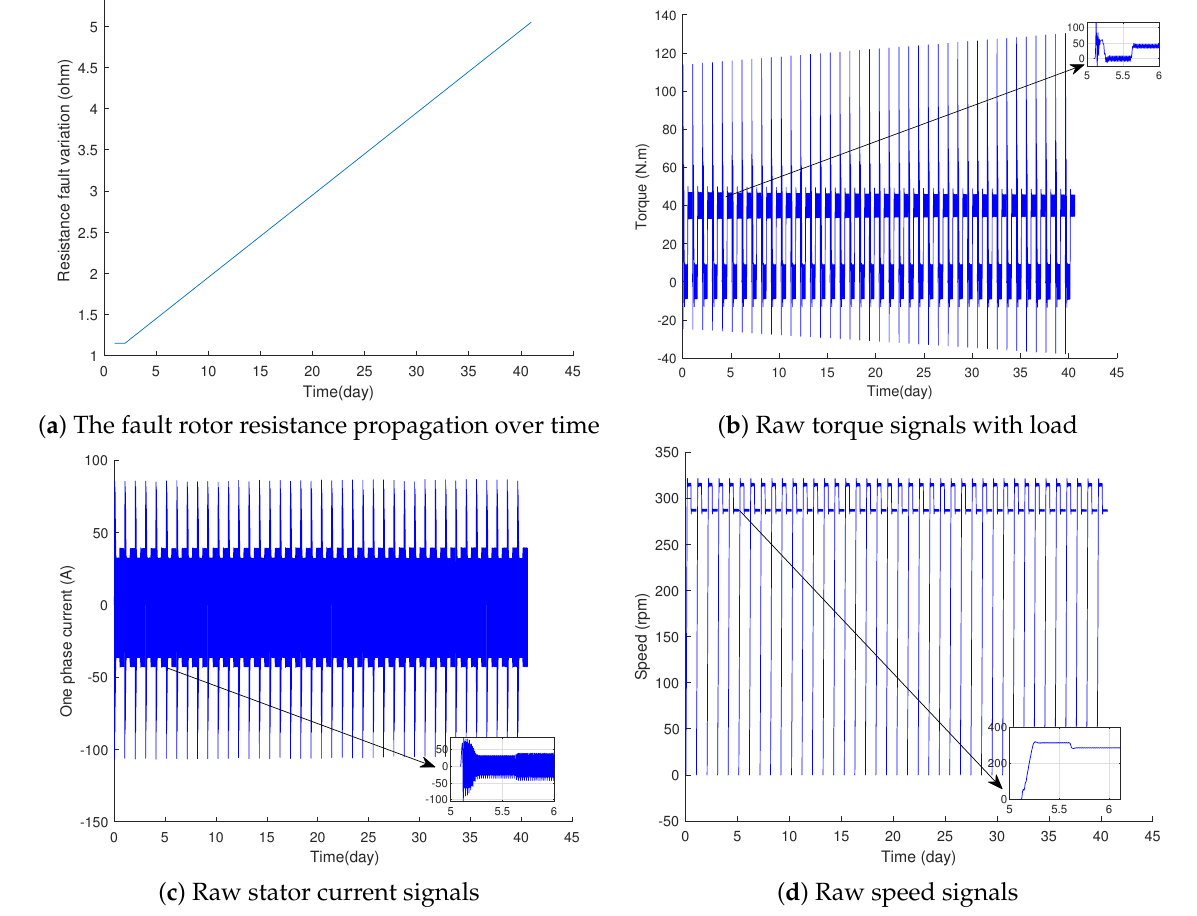
Figure 4. The fault propagation over time and the raw collected